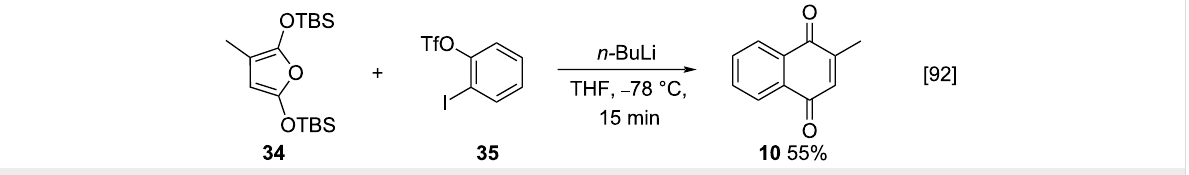
Scheme 8: Furan 34 used as a diene in a Diels–Alder reaction for the synthesis of menadione ( 10 ).